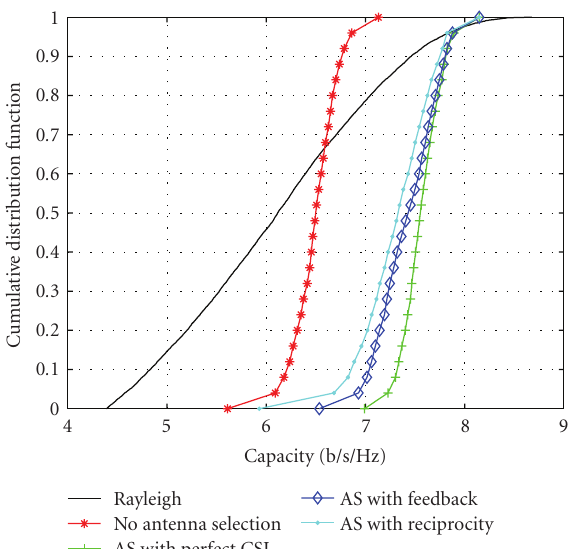
Figure 6: The cumulative distribution function of capacity at Location 1.